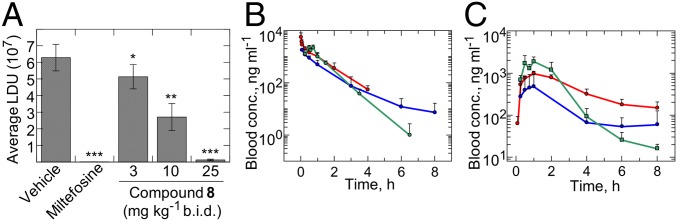
In vivo efficacy and blood exposure of 8. (A) Therapeutic efficacy of 8 in a mouse model of VL (L. donovani, LV9). Data correspond to mean Leishman Donovan units (LDUs) for mice treated with 8, miltefosine, or vehicle alone (n = 5). Unpaired t tests confirmed that the reduction in parasite burden evident in all treated mice is statistically significant compared with untreated control animals, with *P = 0.0441 and **P = 0.0037 for mice treated with compound 8 at 3 and 10 mg/kg, respectively, and P < 0.0001 for mice treated with miltefosine and compound 8 at 25 mg/kg. Blood levels of 8 after a single i.v. dose at 3 mg/kg (B) or a single oral dose at 10 mg/kg (C) to male CD-1 mice (blue), male SD rats (red), and male beagle dogs (green). The profiles are represented as mean ± SD. The y axis is represented as a logarithmic scale. b.i.d., twice a day.